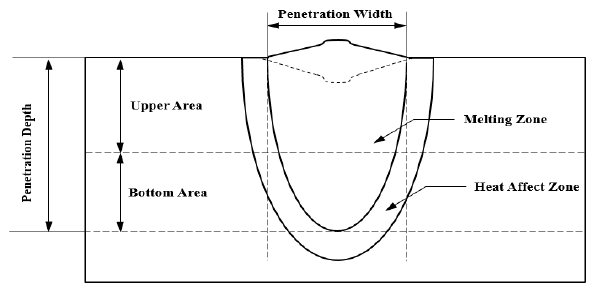
Figure 3. A schematic diagram of penetration geometry.